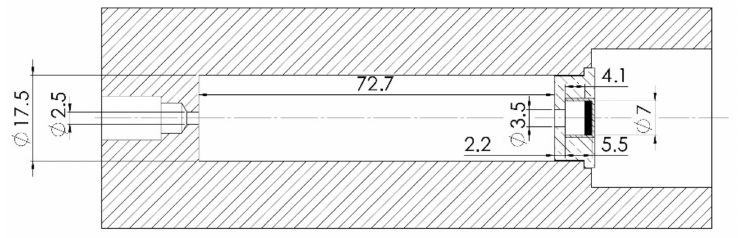
Figure 2. Dimensions of the chamber.